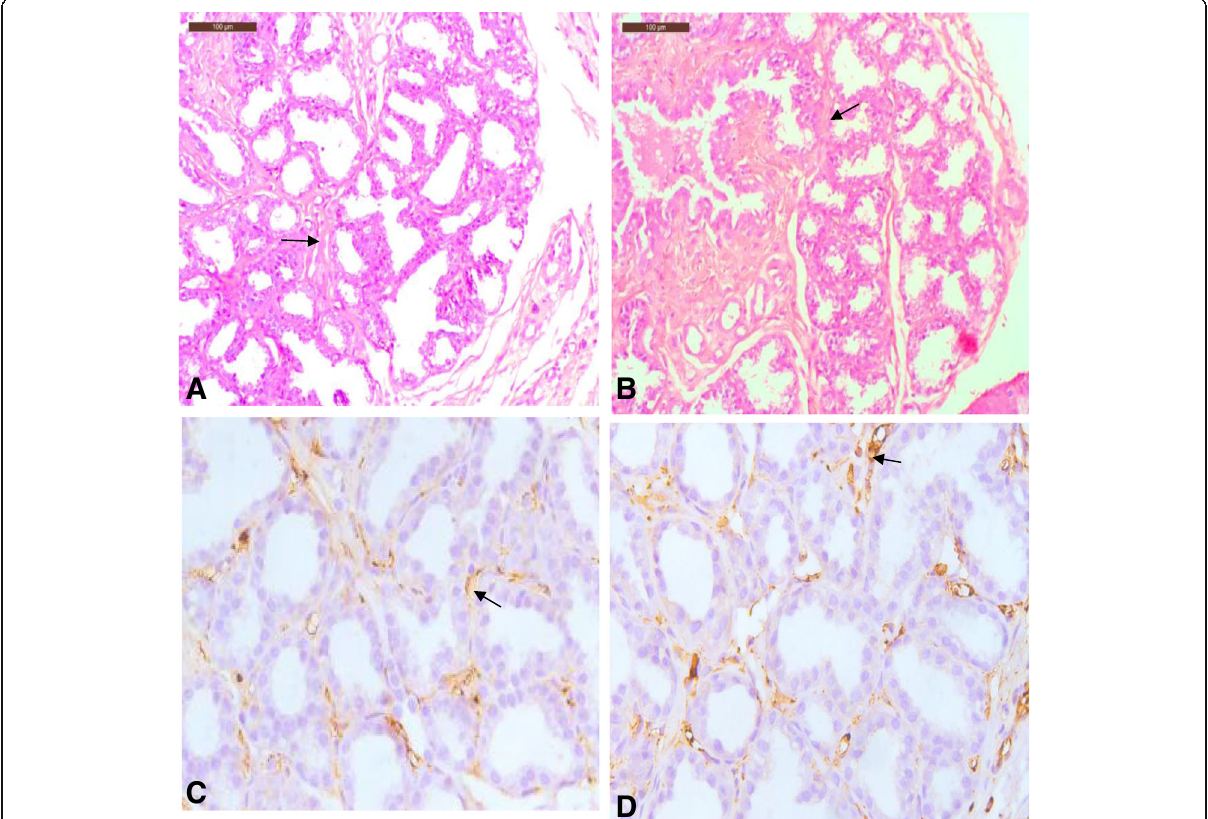
Fig. 2 a In mammary gland (bar = 100 μ m), the stromal connective tissue further recedes (arrow) and the alveolar buds progressively increased in the control group. H&E, × 200. b In mammary gland of 5 mg treated (bar = 100 μ m), the alveolar buds increased and connective tissue recedes (arrow). H&E, × 200. c The epithelial of ducts does not show positive staining, but stromal tissue (arrow) shows faint positive staining in control group of the mammary gland (bar = 50 μ m), × 400. d The epithelial of ducts does not show positive staining, but stromal tissue (arrow)